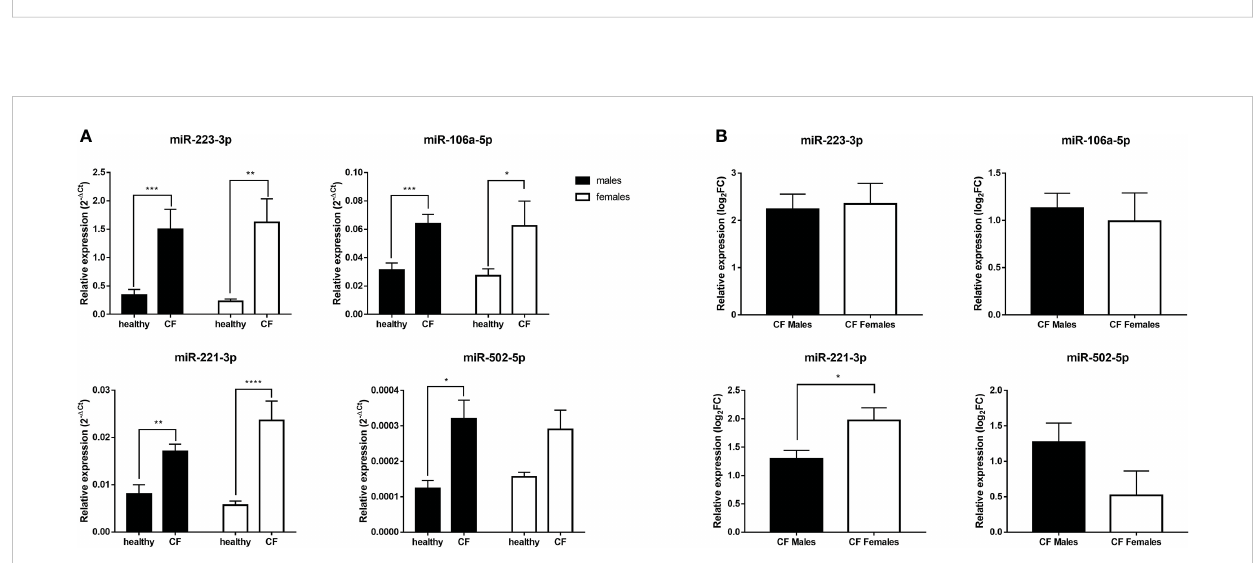
FIGURE 3 (A) Sex-based comparative study of the expression of X-linked miR-221-3p, miR-502-5p, miR-223-3p and miR-106a-5p in blood leukocytes of male healthy controls (n=10) versus CF males (n=15) and female healthy controls (n=10) versus CF female patients (n=14). The values (2 - D CT ) were normalized with the internal control SNORD95. (B) Sex-based comparative study of fold change values (log 2 (2 - DD CT )) of X-linked miR-221-3p, miR- 502-5p, miR-223-3p and miR-106a-5p expression in blood leukocytes between CF males (n=15) and CF females (n=14). The fold change values (log 2 (2 - DD CT )) are relative to those from healthy male or female controls (n=10/group). Graphs show the mean ± SEM. *p<0,05; **p<0,01; ***p<0,001; ****p<0,0001 (Mann Whitney U test).